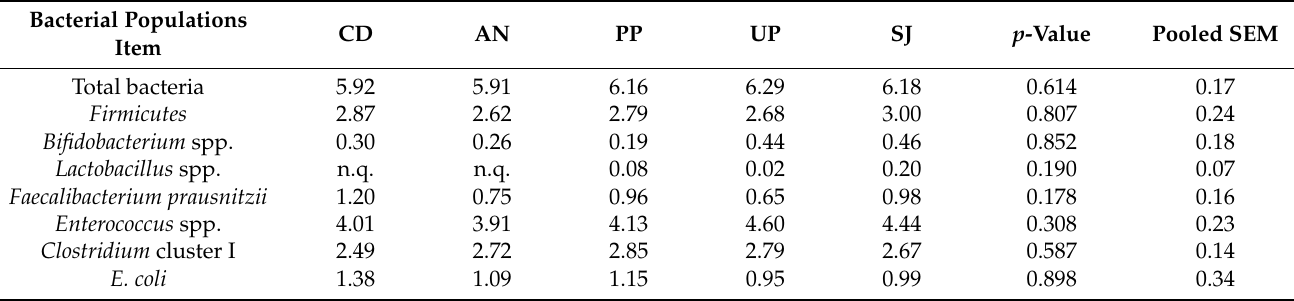
Table 4. Microbial analysis (log copies DNA/ng DNA) of feces from dogs fed with a control diet supplemented or not with different intact seaweeds.